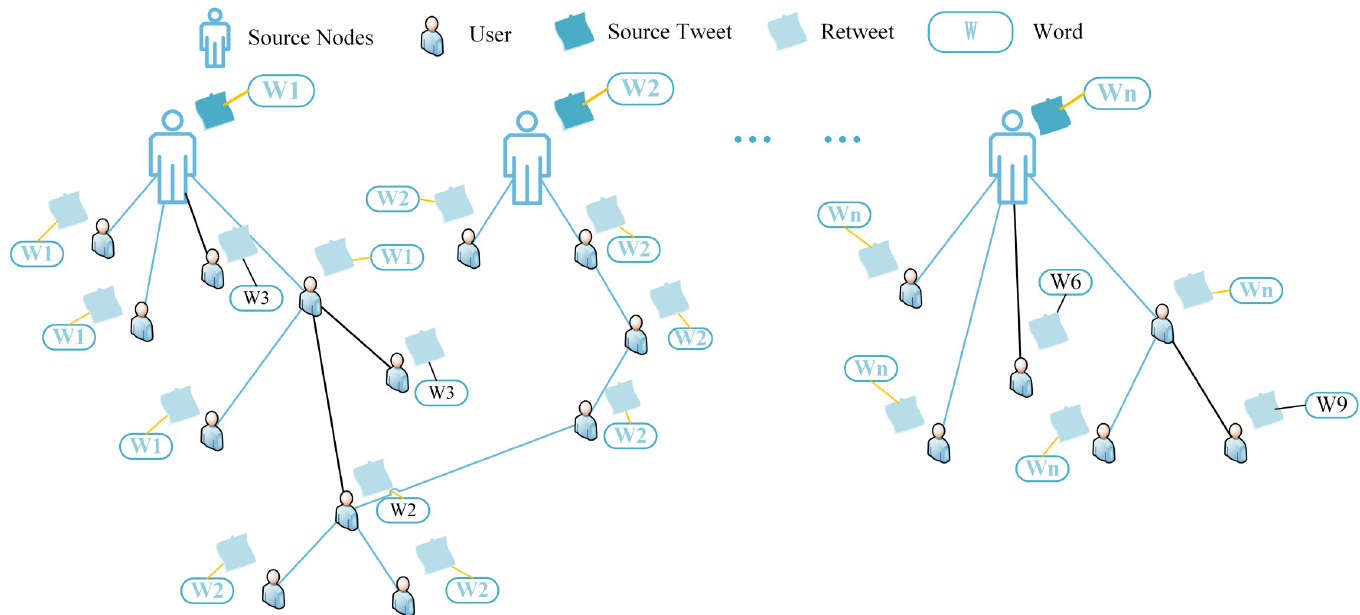
Fig 2. Source tweet-word propagation graph of S ti